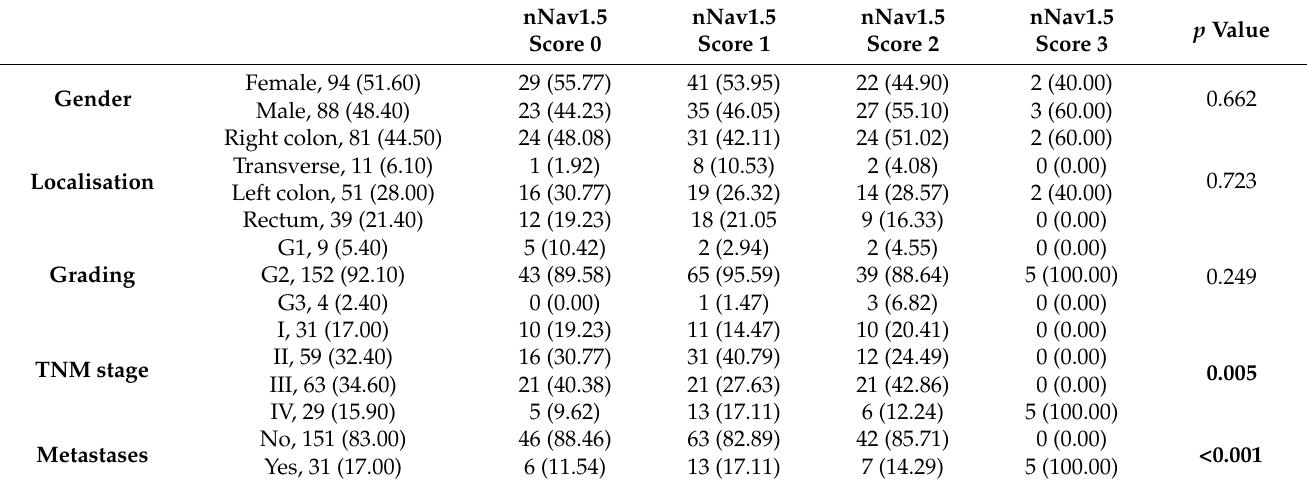
Table 2. Association between nNav1.5 expression and clinicopathological parameters. Case numbers are shown with the percentage in brackets. Statistically significant associations ( p < 0.05) are highlighted in bold (Chi-Square test or Fisher Exact